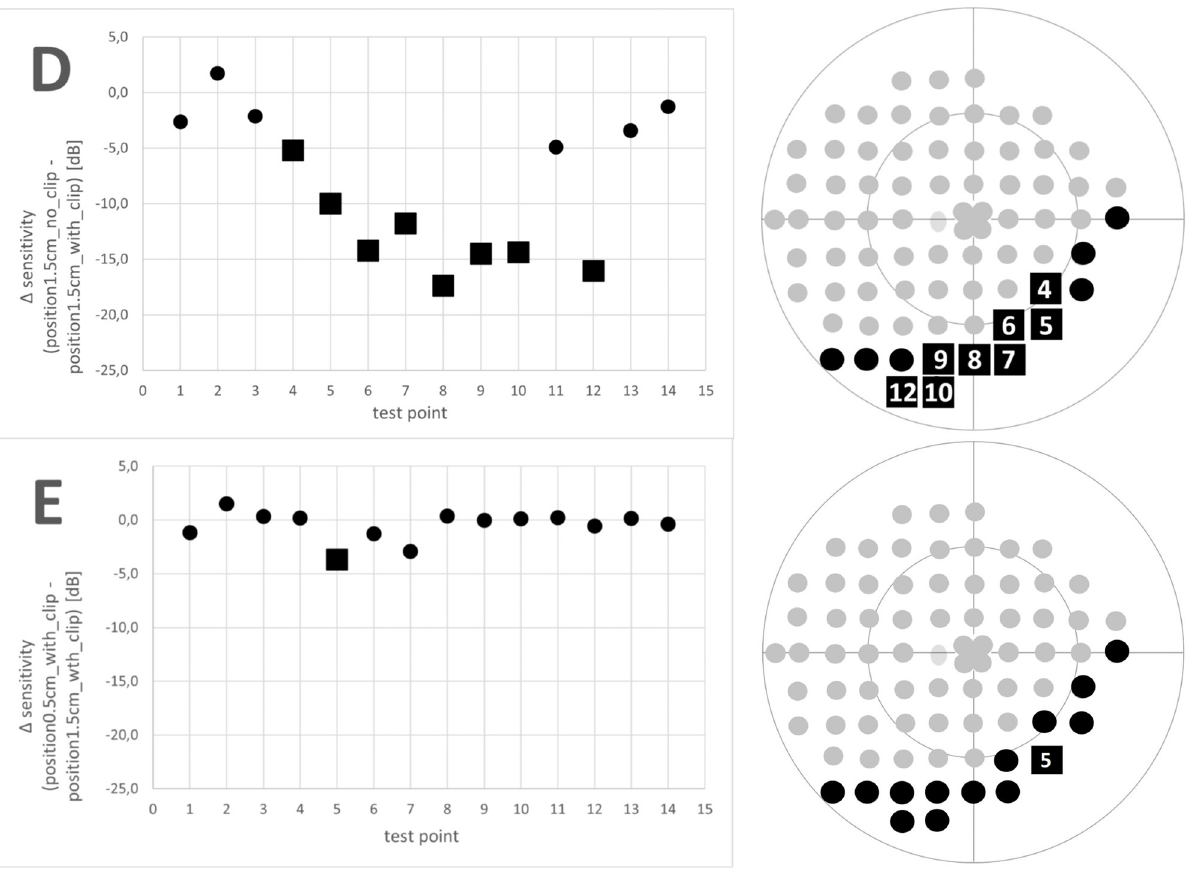
Fig 4. Differences in sensitivity between D: Position 1.5cm_no_clip compared to position 1.5cm_with_clip and E: Position 0.5cm_with_clip compared to position 1.5cm_with_clip ; mean Δ sensitivity; the square represents significant differences (p < 0.05); the circle represents no significant difference.